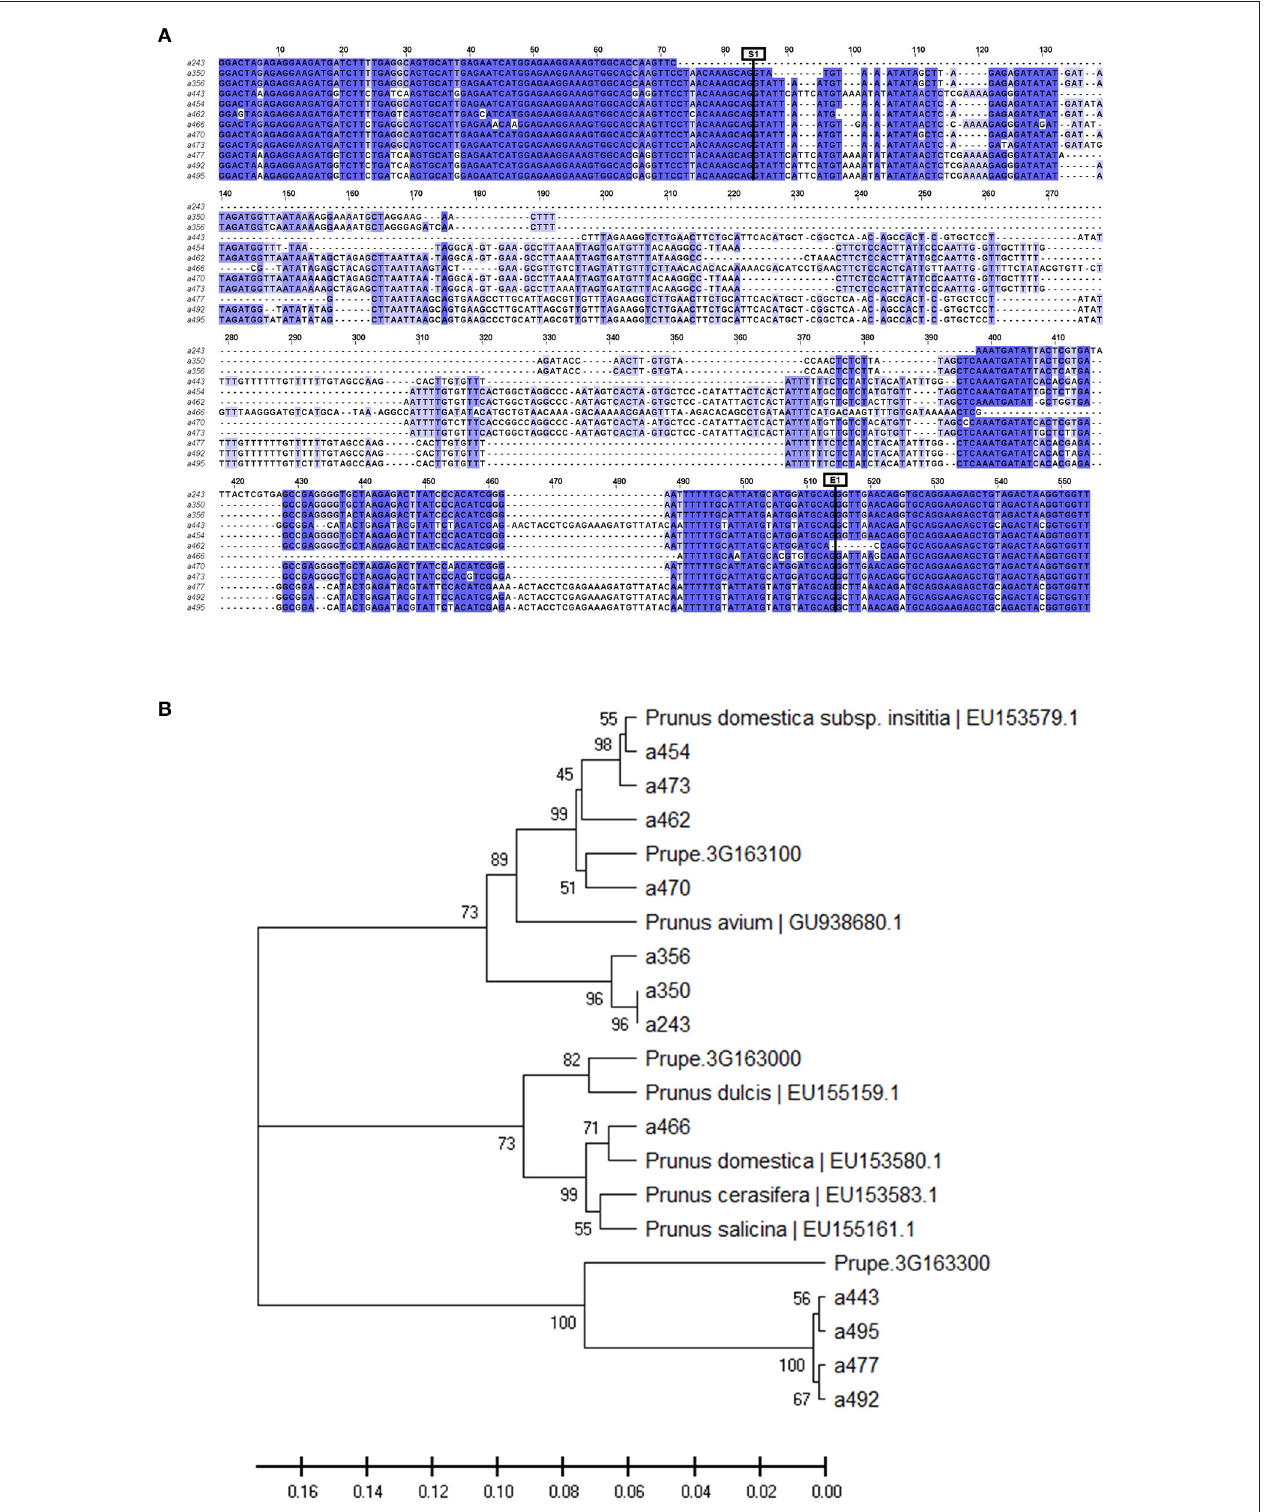
FIGURE 1 | (A) View of the alignment of the 12 cloned allele sequences (a243 to a495). Intron starts at position 85 (S1) and ends at position 514 (E1). (B) Phylogeny tree grouping the cloned sequences with other MYB10 Prunus sequences from the NCBI database and the genes of peach MYB10.1 (Prupe.3G163100), MYB10.2 (Prupe.3G163000), and MYB10.3 (Prupe.3G163300).